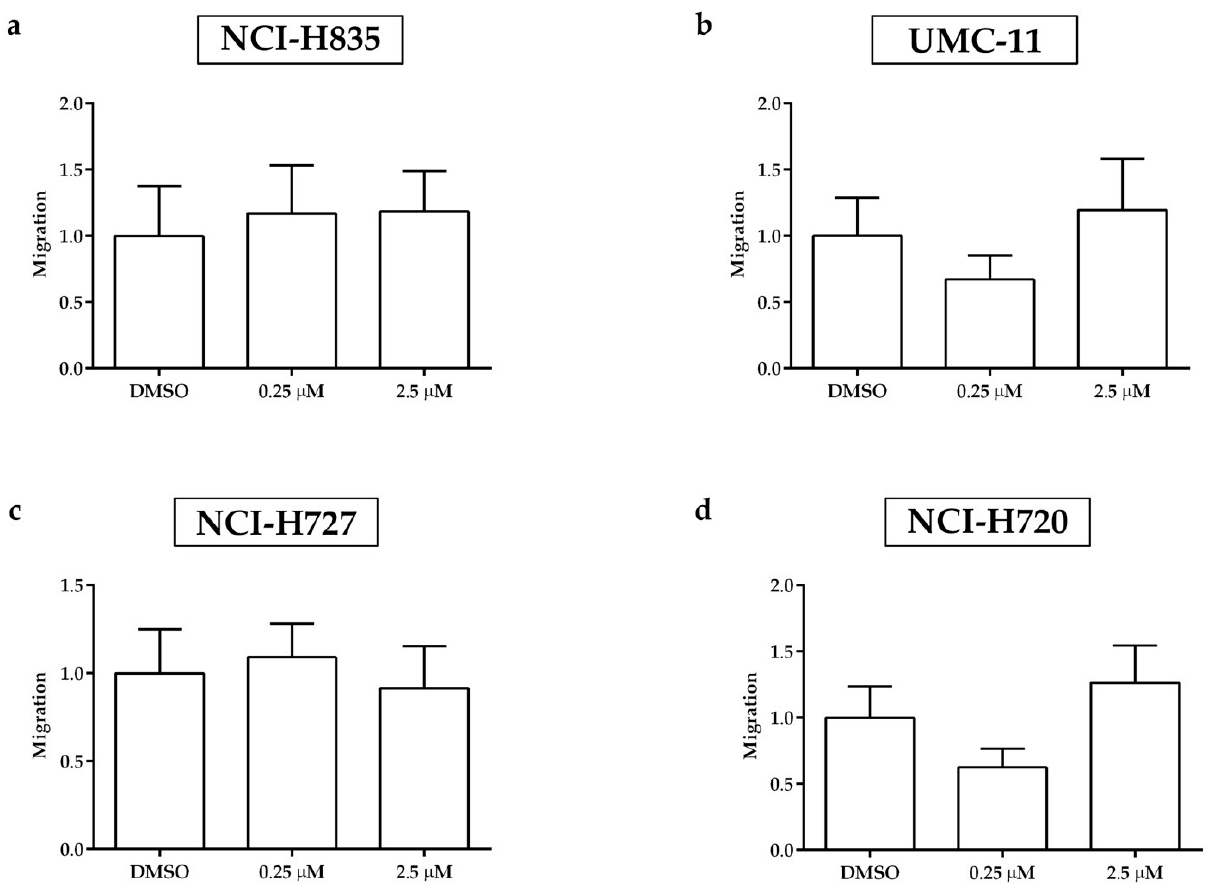
Figure 7 . Effects of sulfatinib treatments on the invasiveness of lung carcinoid cells in grafted zebrafish embryos. Quantification of cell spread in the tail of embryos injected with NCI-H835 ( a ), UMC-11 ( b ), NCI-H727 ( c ), and NCI-H720 ( d ) cells at 48 hpi after 0.25 and 2.5 µM sulfatinib 48 h treatments. As an arbitrary unit of migration, we considered the number of fluorescent particles in the tail. DMSO values have been set to 1.0. Graphed values represent the mean ± S.E.M.